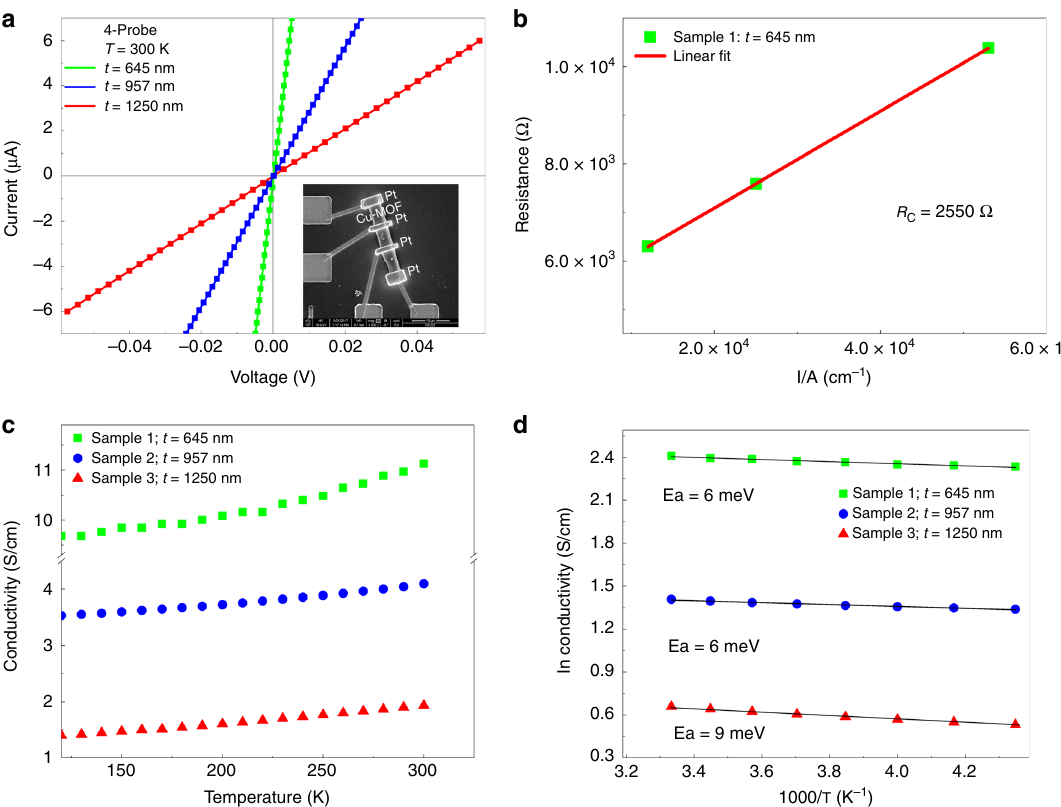
Fig. 3 Electrical properties of 1 . a Current versus voltage curves for different thicknesses of 1 by four-probe measurement. b Contact resistance of sample 1 with a thickness of 645 nm. c Temperature-dependent conductivity of 1 at 0.1 V obtained by the four probe method. d Presentation of a relationship for the Arrhennius curve of 1 between ln (conductivity) and 1000/ T (K − 1